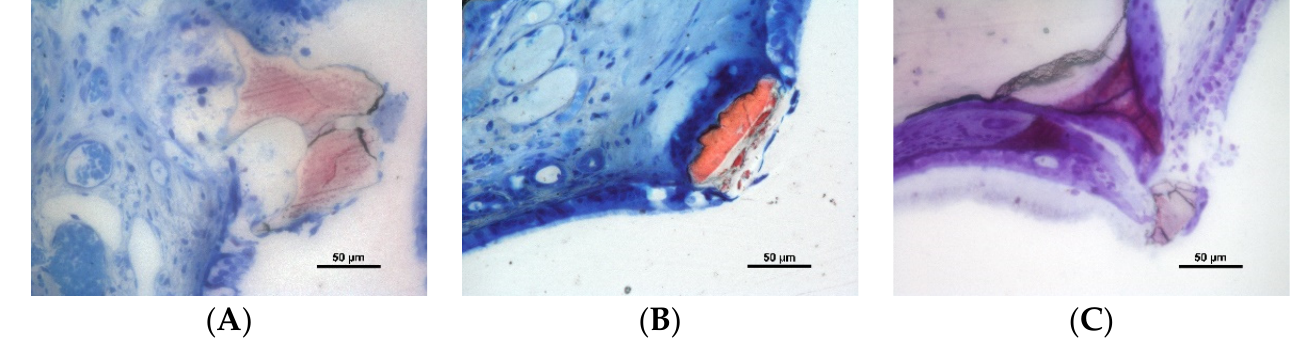
Figure 5. Photomicrographs of ground sections. Granules of low-T granules at the time of being expelled from the elevated space through the sinus mucosa. ( A , B ) Stevenel’s blue and alizarine red stain; ( C ) toluidine blue stain. Some granules were found expelled through the sinus mucosa (Figure 5A–C). The width of the pristine sinus mucosa was similar in both groups and periods (mean values ranged between 54 µ m and 61; Table 1). After 2 weeks of healing, in the low-T group, the sites of the elevated sinus mucosa presenting a width < 40 µ m numbered 118, eleven of which were <10 µ m (Table 2). The minimum width registered was 5 µ m. Eight perforations were found in the low-T group in six sinuses. The largest perforation was about 2.4 mm in dimension, while five perforations were between 100 and 500 µ m, and two were <100 µ m. Table 1. Histometric data.